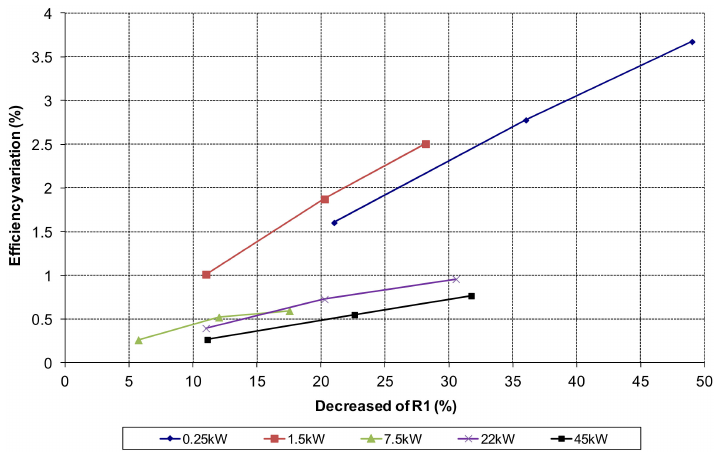
Figure 7. Efficiency variation versus decreased of R 1 in all the motors (equal heating